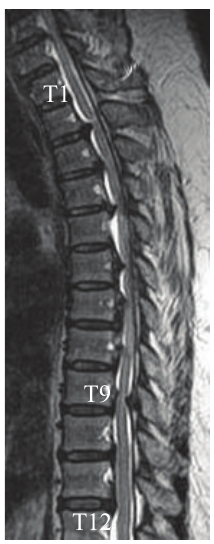
Figure 2: T1-weighted magnetic resonance imaging showed areas of OPLL extending from T2 to T8 and T9/T10